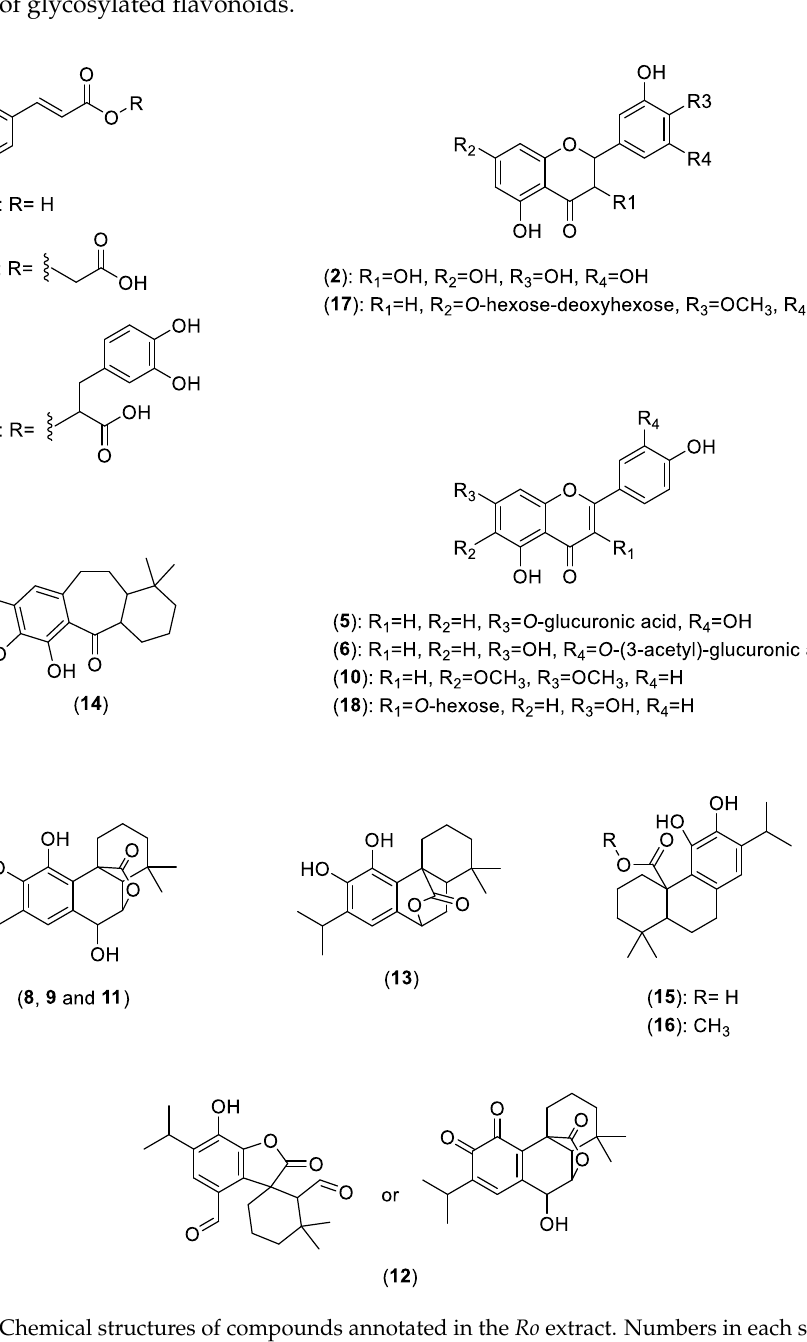
Figure 5. Chemical structures of compounds annotated in the Ro extract. Numbers in each structure refer to those presented in Table 2.